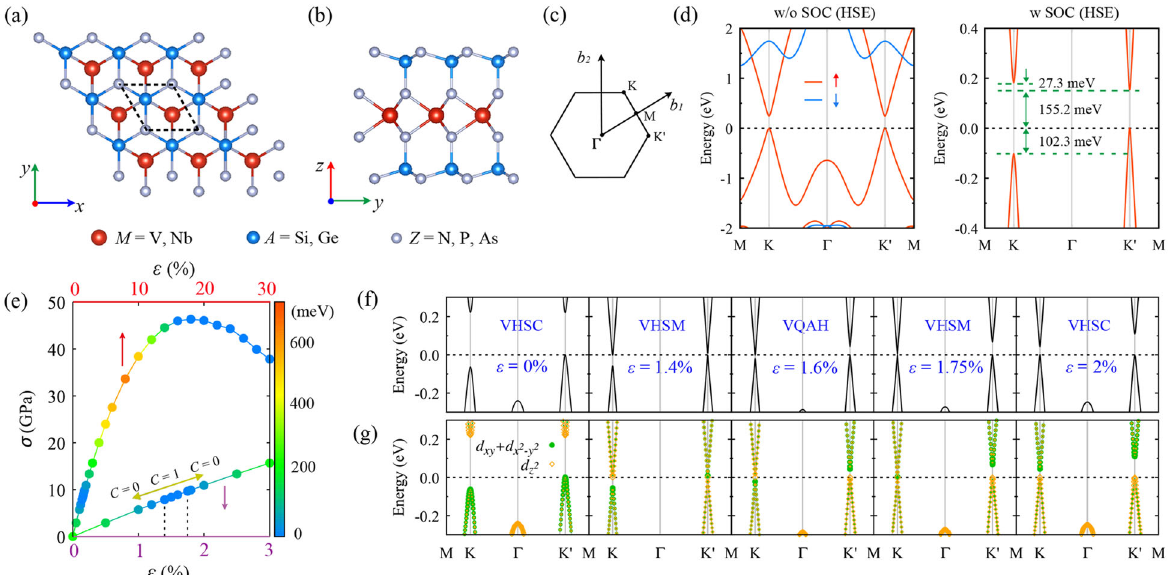
Fig. 2 Valley-dependent topological phase transitions in VSi 2 N 4 . a , b The top and side views of MA 2 Z 4 materials family. The dashed lines in ( a ) indicate the 2D primitive cell. c The Brillouin zone of MA 2 Z 4 . d The band structures of VSi 2 N 4 were calculated by the hybrid functional without SOC (left panel) and with SOC (right panel). ( e ) The stress-strain curve of VSi 2 N 4 . The top x -axis plots the whole strain range of 0 – 30%, while the bottom x -axis plots the small strain range of 0 – 3%. The colors indicate the magnitudes of the bandgap, and the corresponding Chern number ( C ) is marked. The evolution of band structure ( f ) and orbital compositions at band edge ( g ) under the strain of 0 – 2%. Various fully spin-polarized valley topological states emerge, including VHSC (0%), VHSM (1.4%), VQAH (1.6%), VHSM (1.75%), and VHSC